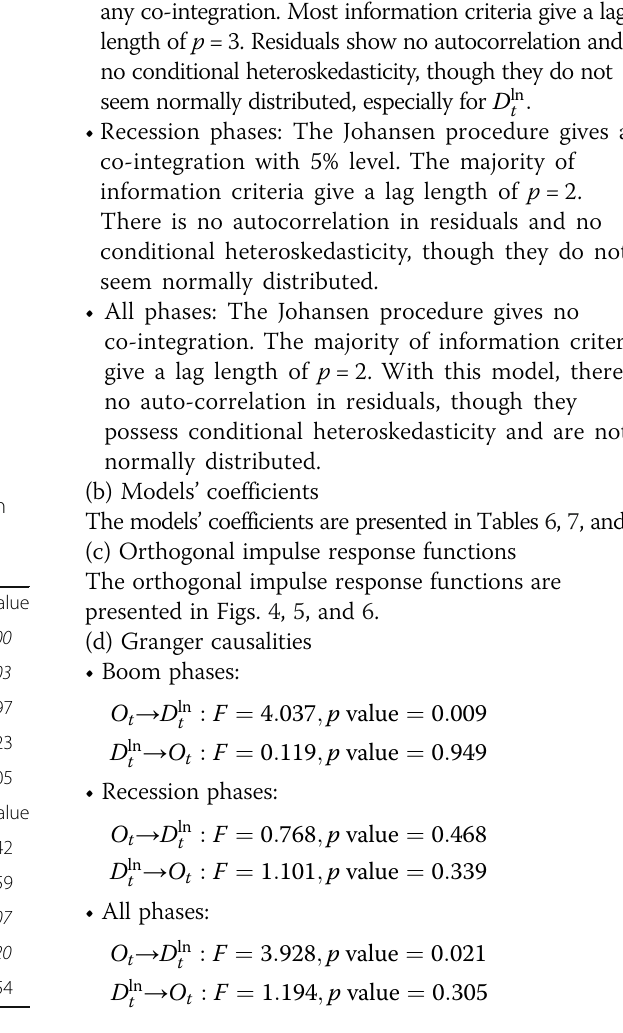
Table 3 Coefficients ’ estimations of a VAR (2) model between the D ln and G ln for boom phases. Top: model for D ln t t model for G ln . Italics: significant results with 5% level t